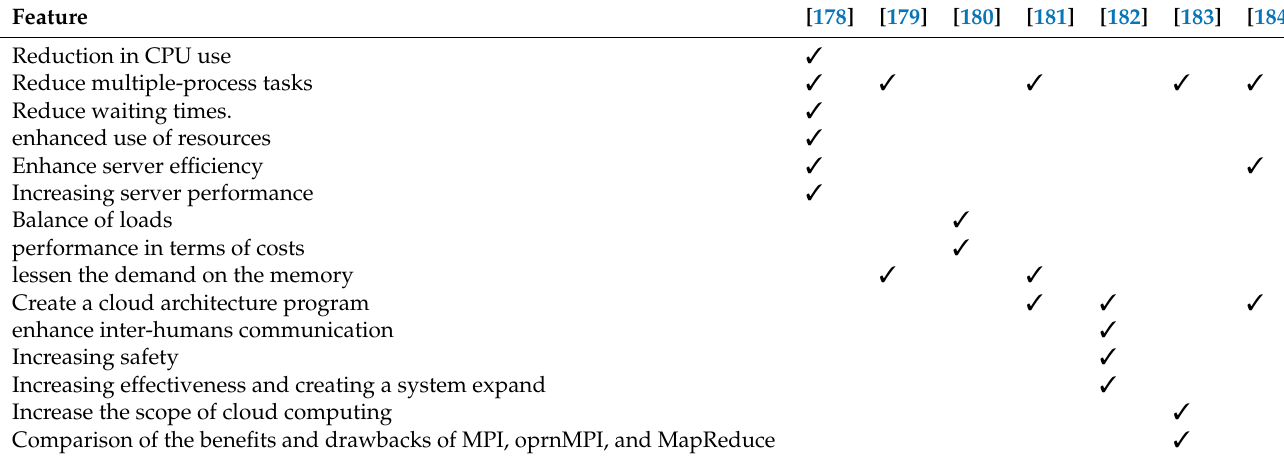
Table 3. Distributed Cloud